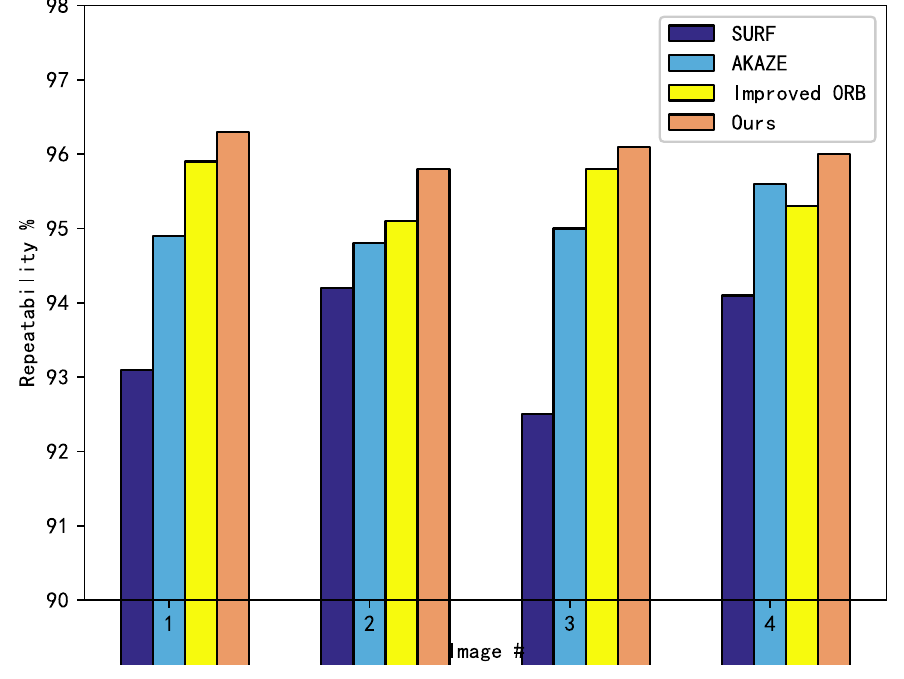
Figure 8. Comparison of Matching rate.